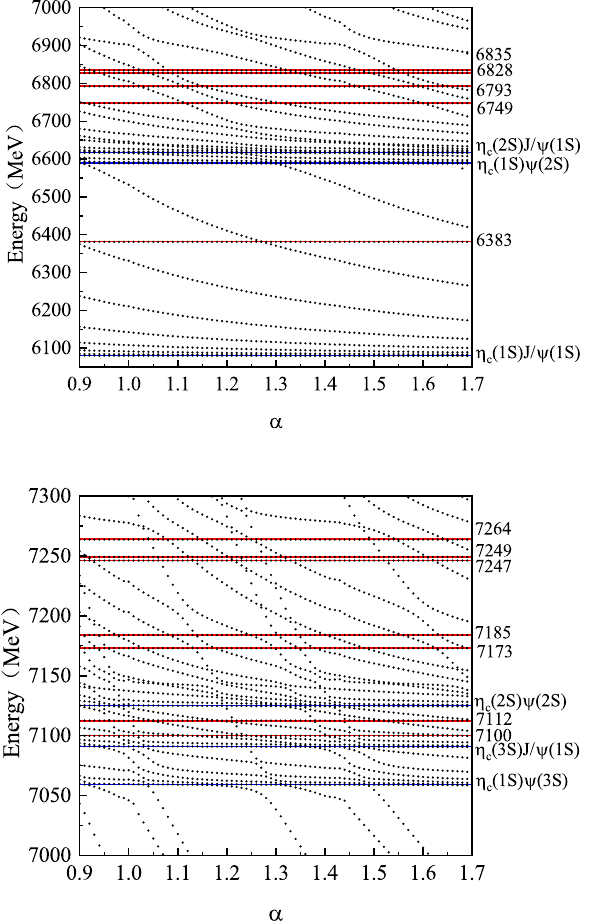
Figure 11. The stabilization plots for the energies of the states for J PC = 1 + − obtained by considering the full-channel couplings with respect to the scaling factor α . Upper for energies 6000–7000 MeV and down for energies 7000–7300